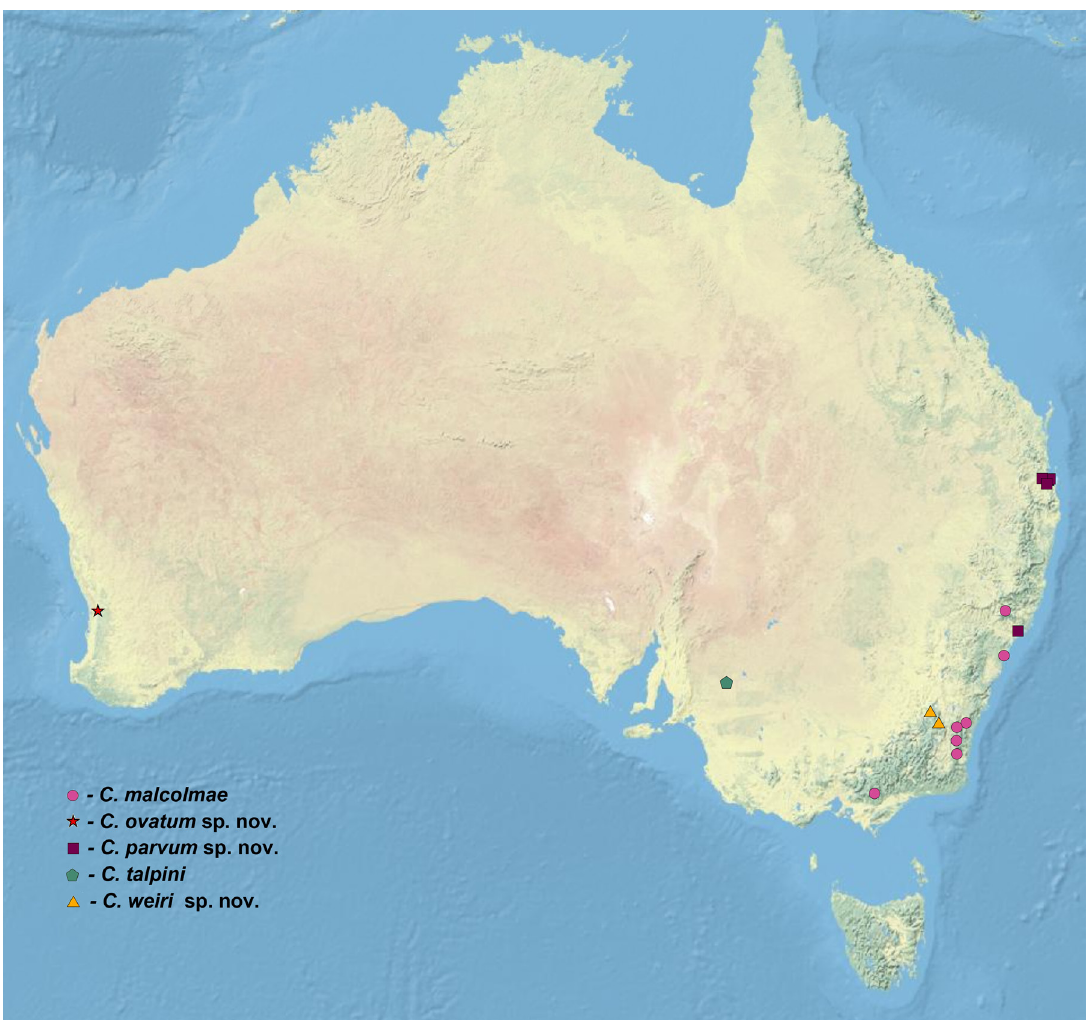
Fig. 11. Distribution of Carvalhoma